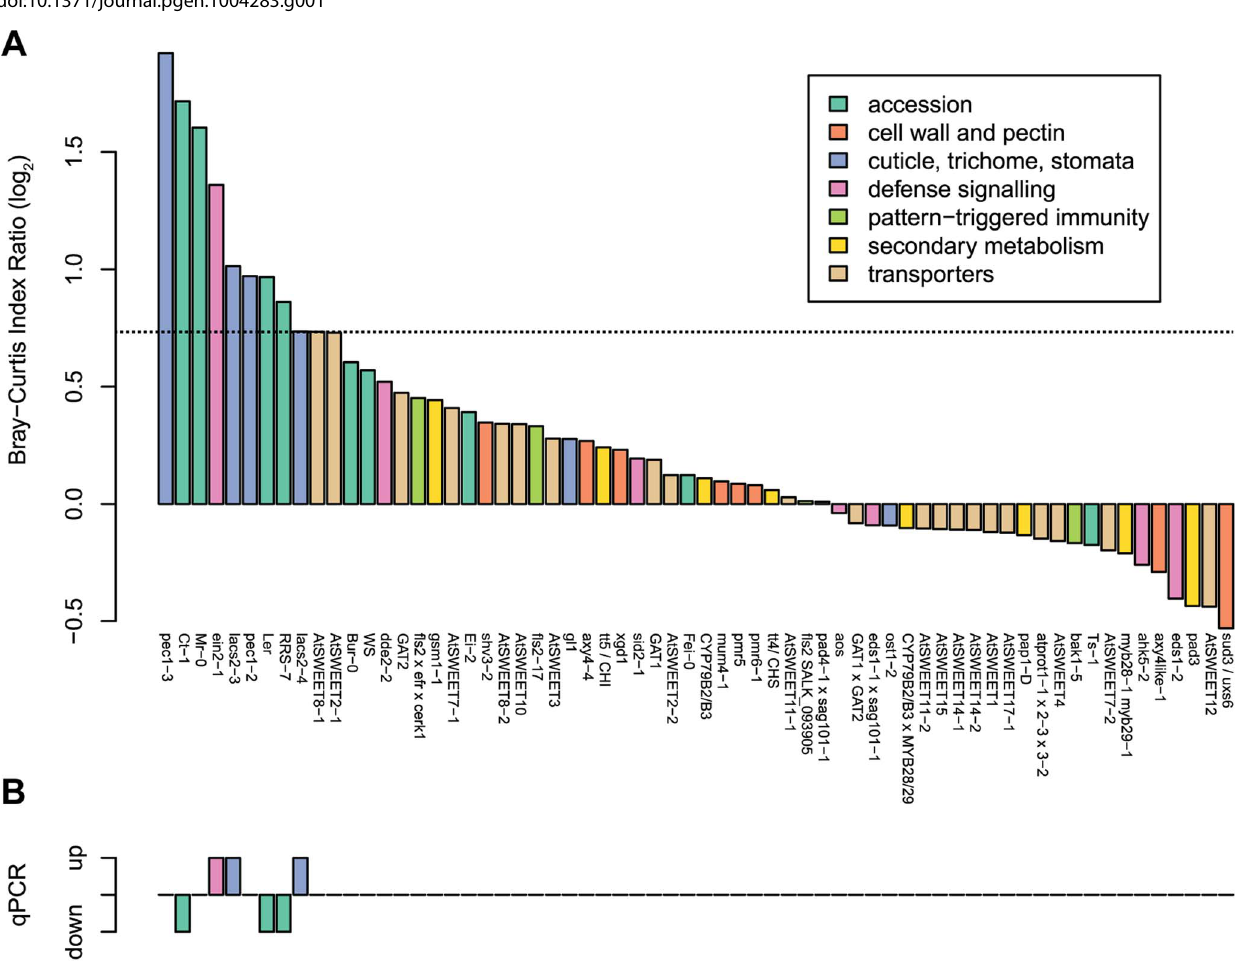
Figure 2. Different A.thaliana plant genotypes (55 in total) were tested for changes in bacterial community composition and abundance in independent experiments. (a) Results of the ARISA analysis. The average Bray-Curtis index was calculated for each genotype compared to the wild-type in pairwise comparisons and divided by the average Bray-Curtis index for each genotype with itself (see Figure S7 for individual values). Col-0 was used to normalize for most genotypes, except for mutants with a different background, which were normalized to their respective background. The horizontal dashed line indicates the limit of reproducibility of the system, mutants very close to this threshold could either be confirmed (Figure 3) or not (Figure S8). (b) Results of the qPCR analysis. The up and down bars indicate higher and lower 16S rRNA gene copy numbers, respectively, compared to the wild-type Col-0 samples (Bonferroni-adjusted P value , 0.05). For each genotype there were 3–4 DNA pools from five plants. The same DNA extracts were used for ARISA and qPCR analysis.